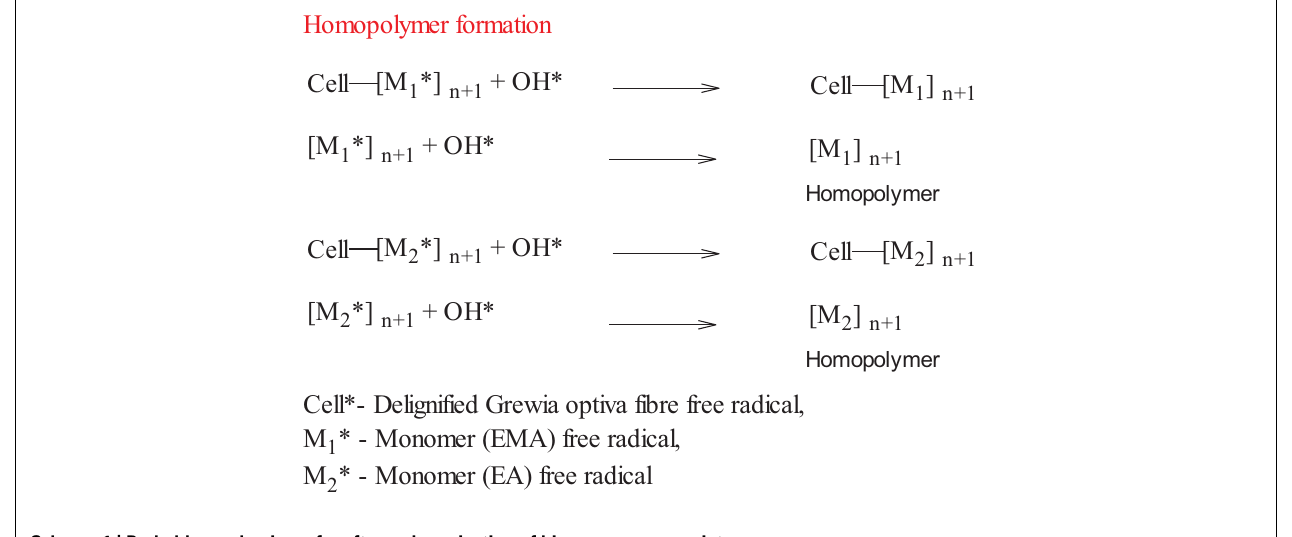
Table 1 | Evaluation of optimum reaction parameter for grafting of binary vinyl monomer mixture onto delignified Grewia optiva fiber.